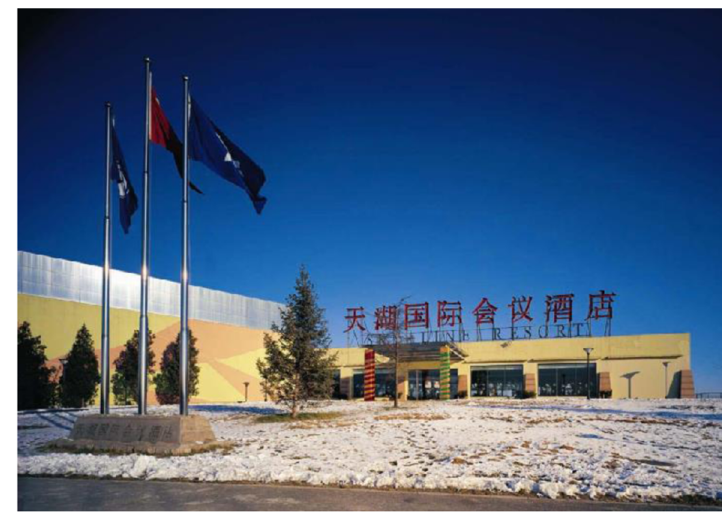
Fig. 15 Beijing Tianhu International Conference Hotel